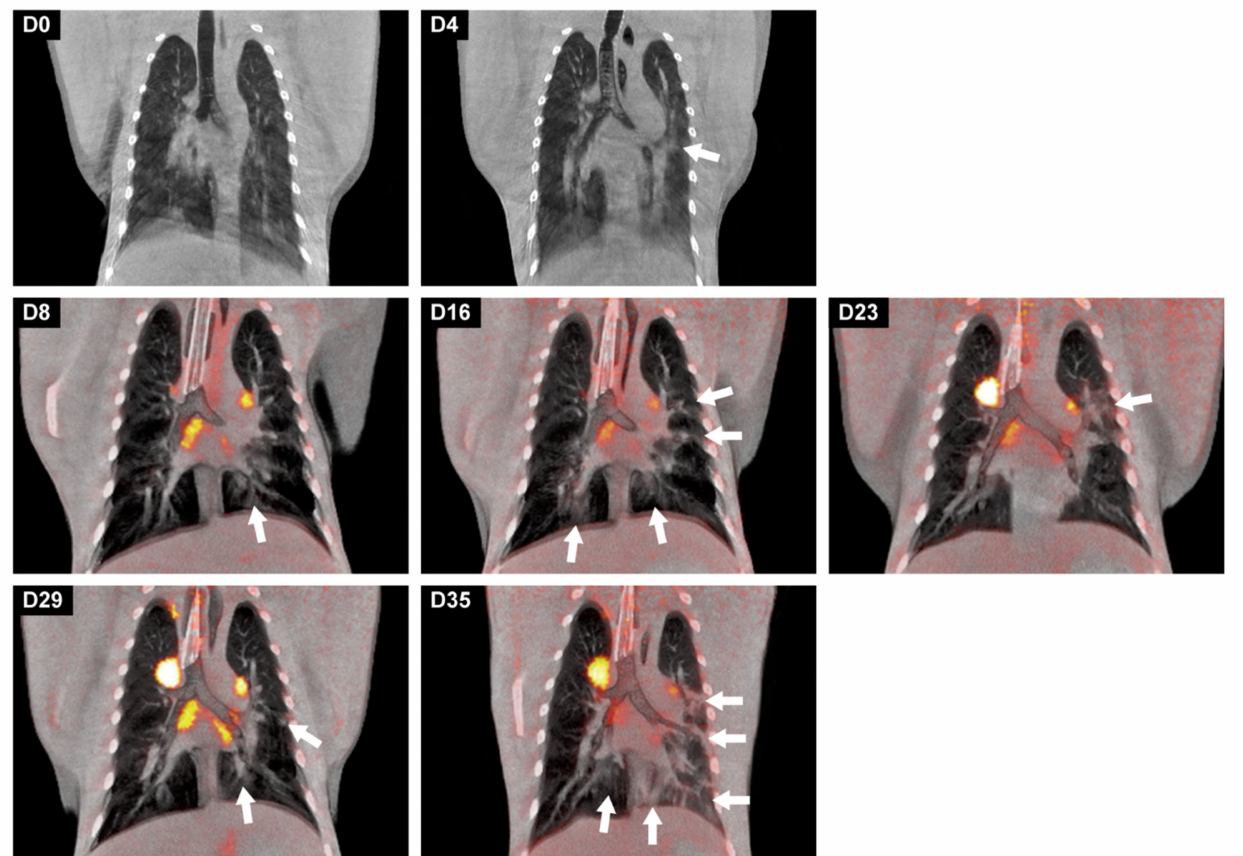
Figure 6. Longitudinal development of both lung lesions and metabolic activity in tracheobronchial lymph nodes of J16017 over time after a SARS-CoV-2 infection. Representative coronal slices with a thickness of 3 mm of J16017 were used for visualization. On days 0 and 4, only CT images were obtained, afterwards, until day 35, CT was combined with PET. The location of the lesions, marked with arrows, differed almost per time point, but are most prominently localized in the left lung on day